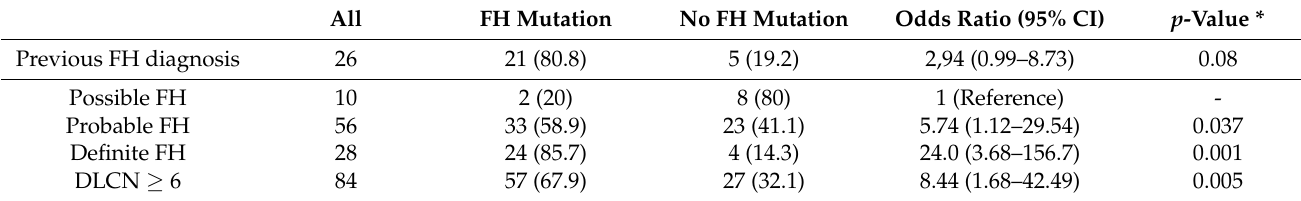
Table 3. Genetic testing